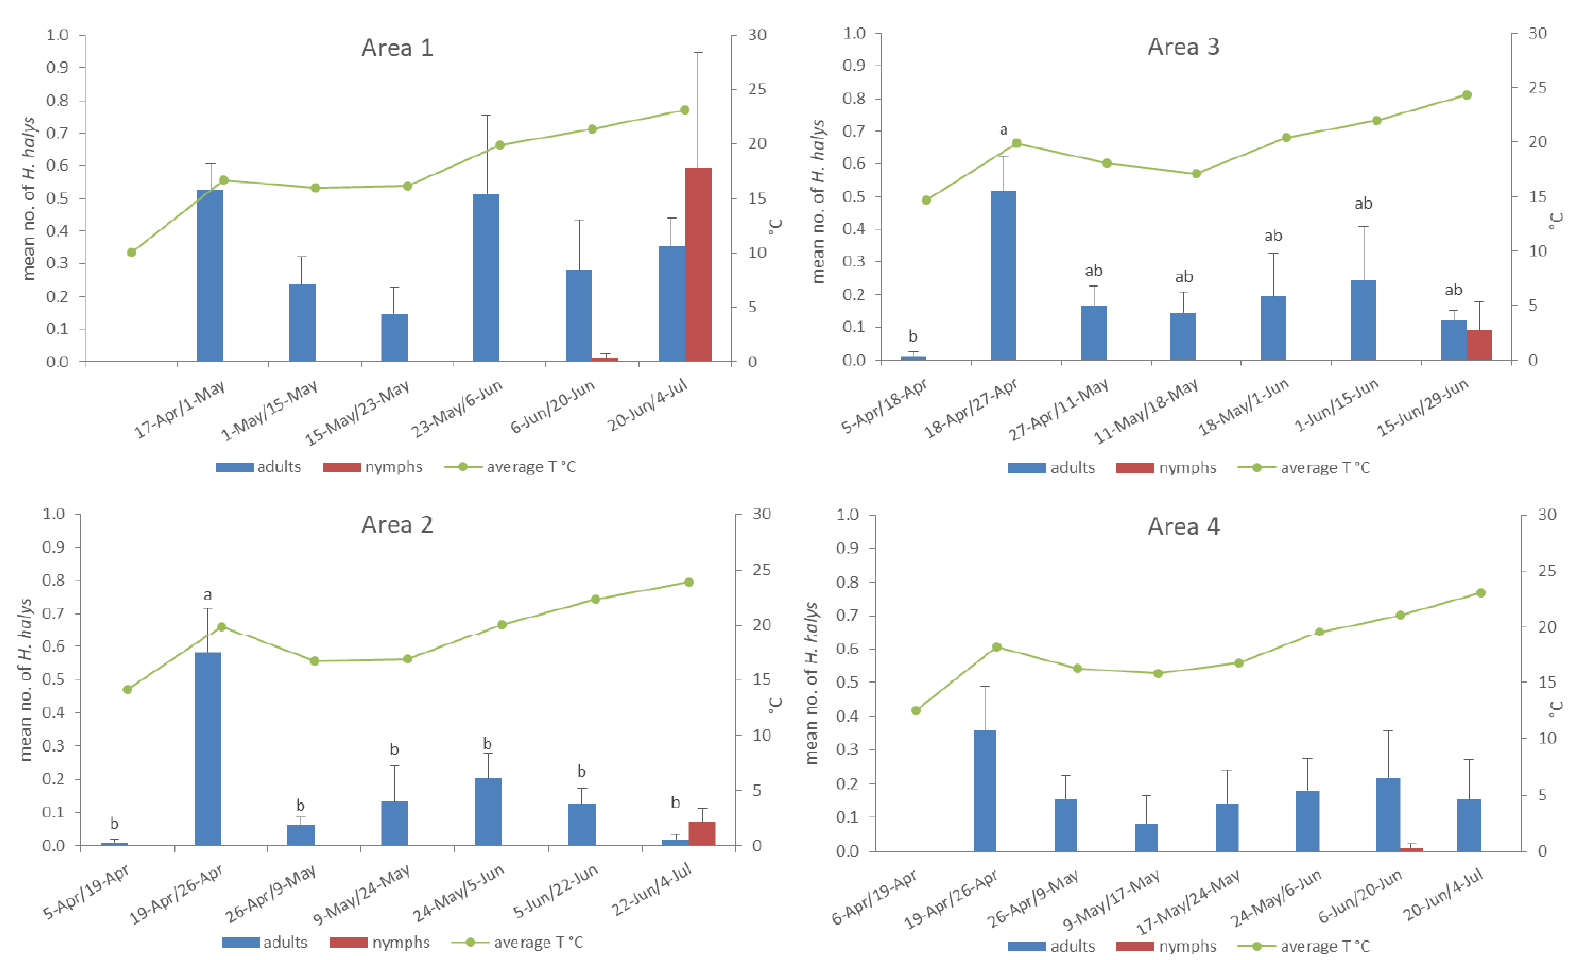
Figure 1. Mean numbers of daily captures of adults and nymphs of Halyomorpha halys per trap and average temperatures (°C) recorded in each area in the sampling period. Bars of adult captures labelled with the same letter are not significantly different (one-way ANOVA, Tukey’s test, p < 0.05).